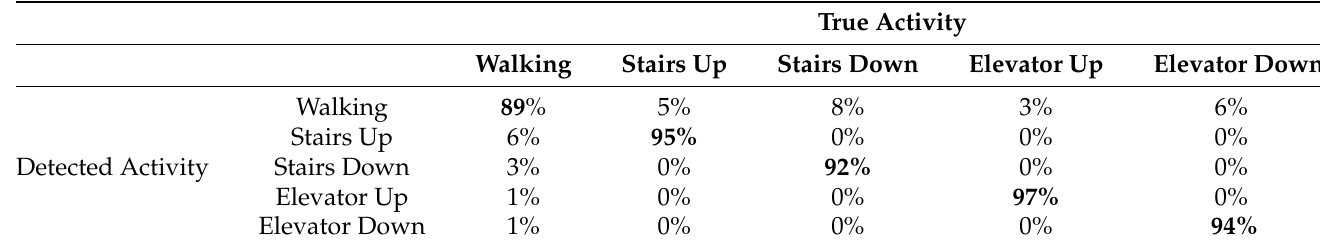
Table 3. Confusion matrix for batch floor transition detection.